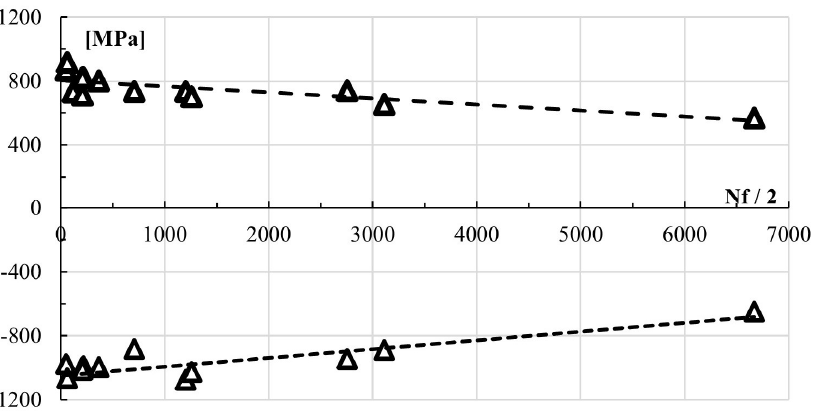
Figure 17. Failure stress at half failure life.